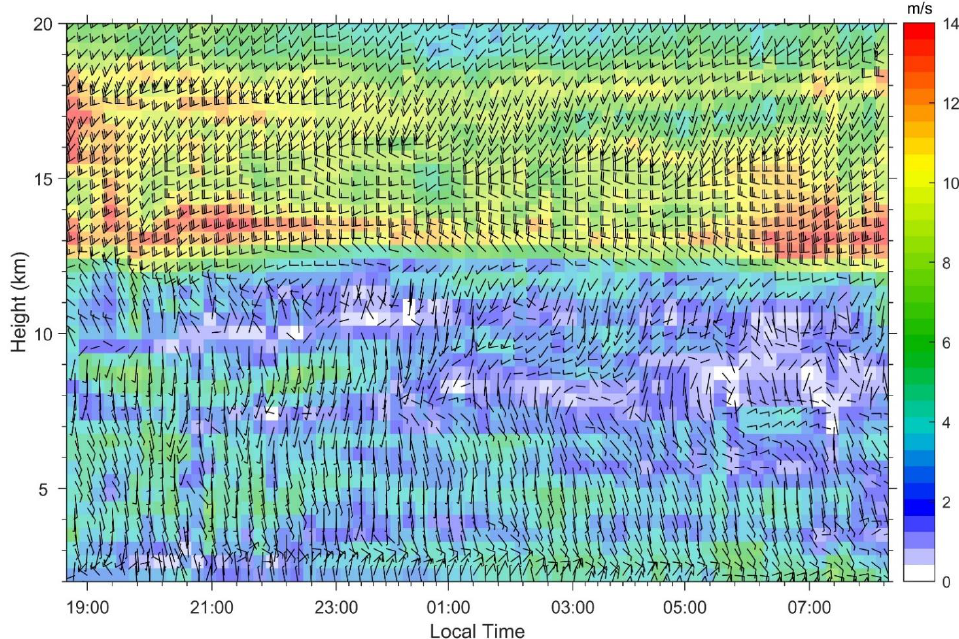
Figure 10. Wind barbs with respect to the local time and height from 19:00 on 18 July 2021 to 09:00 on 19 July 2021, in experiment #2. In addition to the shape of the array, the background color also represents the amplitudes of the wind. The unit is m/s.